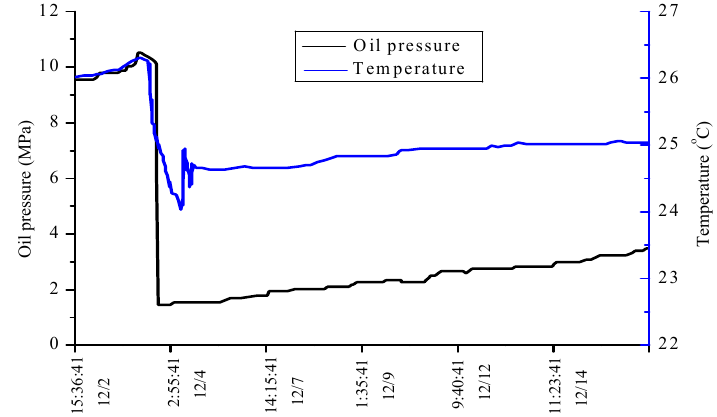
Figure 8. Real-time comparison between gas pressure and temperature during the mining process.